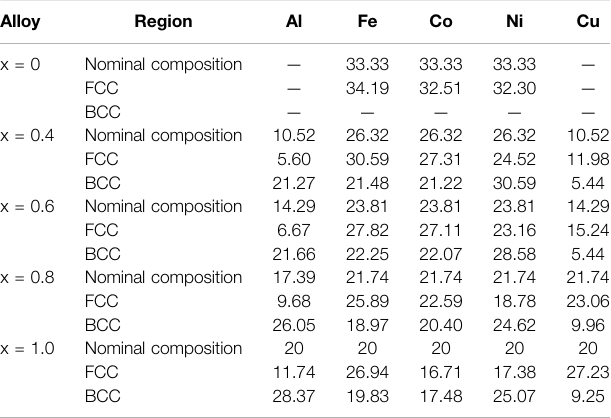
TABLE5| EDS/TEMresults(inat%)ofthephasesofbulkFeCoNi(CuAl) x MEAand HEAs. Alloy